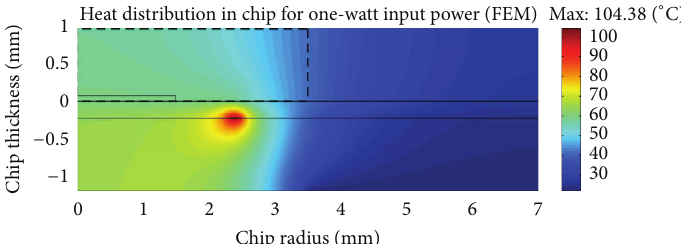
Figure 6: Steady-state temperature distribution of the cross-section of the chip calculated by the FEM. The axis of symmetry is along the left vertical side. The lines bound four domains assigned to the thermals conductivities of glass, PDMS, and water. The glass plates and PDMS layer are 1.1mm thick and 254 m thick, respectively. The thin rectangle on the left defines the PCR chamber. The heater is located at the point of the highest temperature in red.